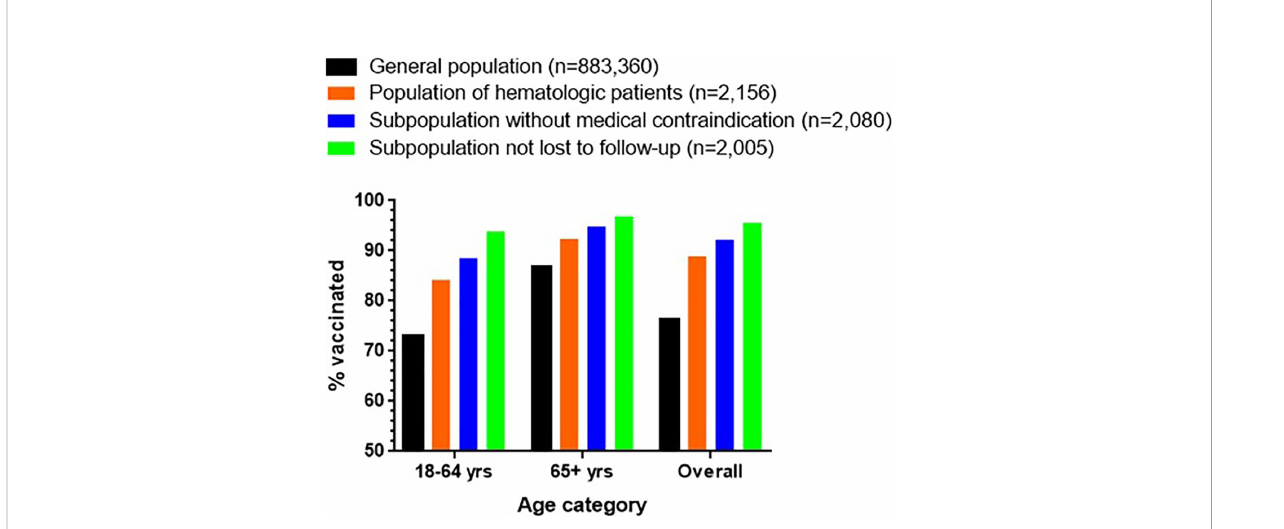
FIGURE 2 Vaccination rates in the general population as well as in the population of hematologic patients living in the Province of Liège. The sub- population of patients without medical contraindication (n=2080) and the subpopulation of patients not lost to follow-up (n=2005) are also displayed. The data are shown for patients 18-64 yrs, ≥ 65 yrs and overall.